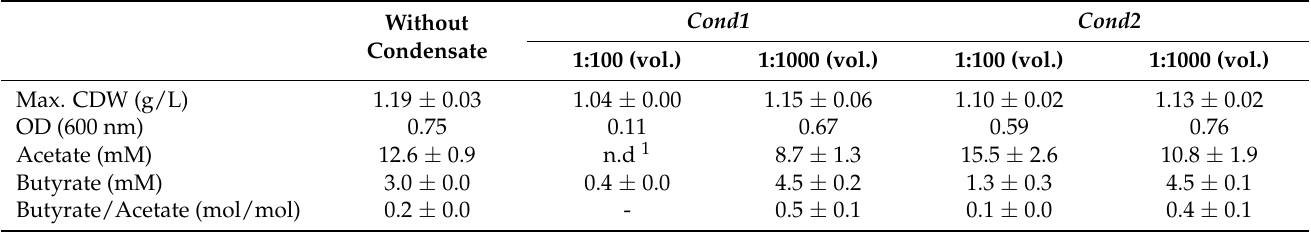
Table 4. Growth, acetate, and butyrate production by B. methylotrophicum during syngas fermentation with or without supplementation of Cond1 or Cond2